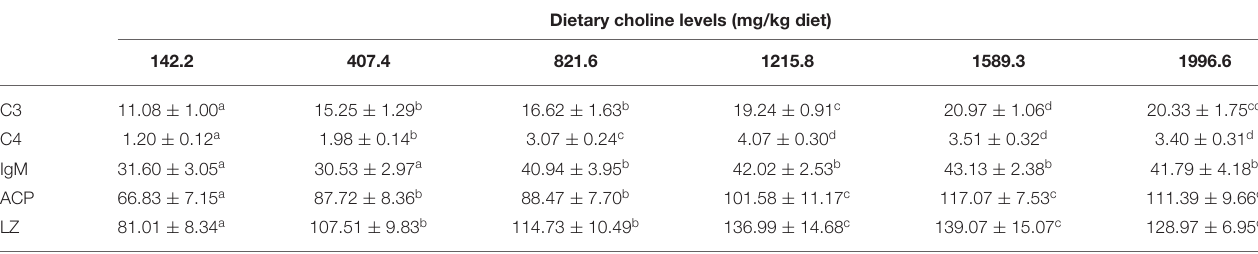
TABLE 4 | Effects of dietary choline (mg/kg diet) on immune parameters in juvenile grass carp ( Ctenopharyngodon idella ) skin 1 . Dietary choline levels (mg/kg